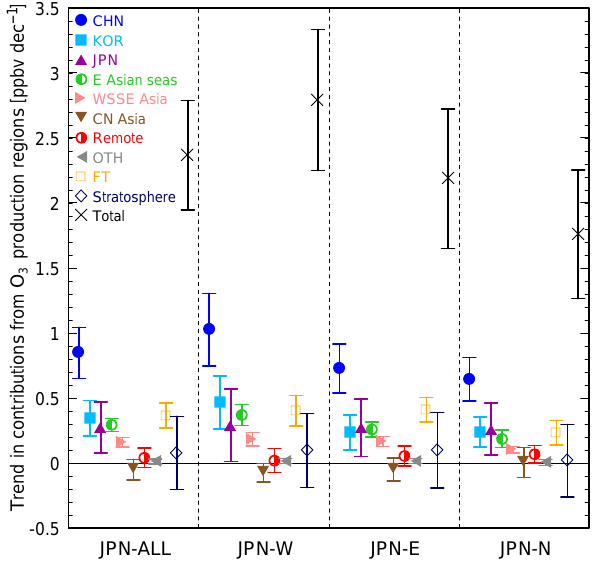
Figure 7. Linear trends in annual mean contributions in 1980–2005 from source regions to surface O 3 over Japan shown in Fig. 6 (JPN- ALL) and those averaged in three subregions in Japan (JPN-W, JPN-E, and JPN-N). Error bars are 95% confidence